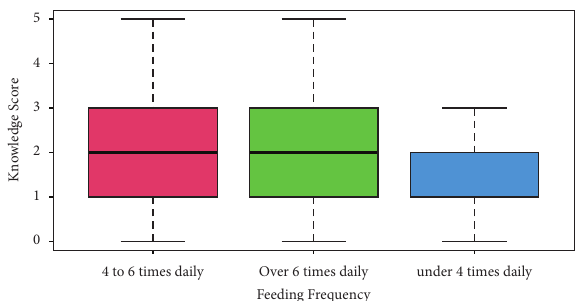
Figure 4: Most mothers reported feeding their babies between four and six times daily (scoring μ � 2.1 points in terms of average knowledge score). Those who fed their infants under four times daily score significantly lower knowledge score ( μ � 1.2 points, p < 0 .